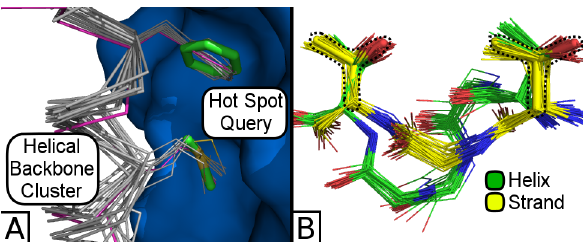
Figure 5. Finding backbones compatible with hot spot residues. (A) A Suns search at 0.7 A˚ RMSD cutoff for two hotspot residues previously identified by RosettaDock [22] for a hemagglutinin binder [20]. The majority of search results are helices that closely match the final designed protein. The search query is shown in thick green sticks, the search result matches are shown as grey a -carbon traces, and the designed hemagglutinin binder is shown as a purple a -carbon trace against a blue hemagglutinin surface. (B) Searching for two threonine side chains at 0.6 A˚ RMSD cutoff reveals two backbone clusters that can connect them, one corresponding to an a helix (green) and the other corresponding to a b sheet (yellow). Black dashed lines surround the original search query, which is represented as thick yellow sticks.